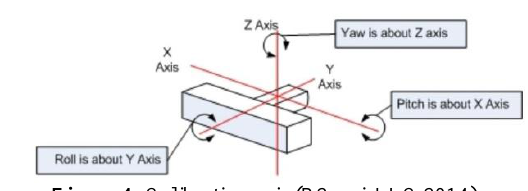
Figure 4: Calibration axis (R2sonicLLC 2014).